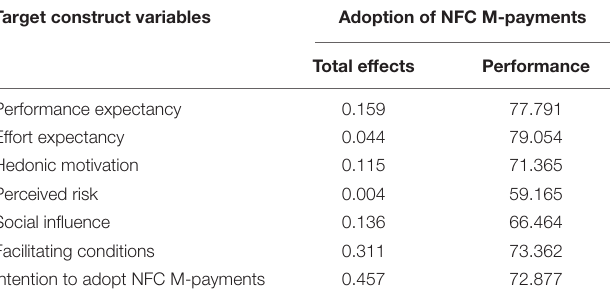
TABLE 7 | Importance-performance